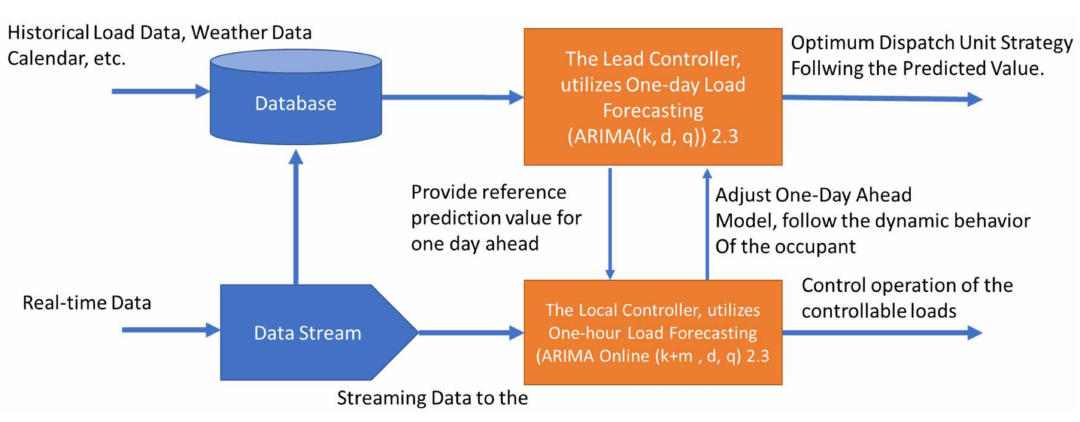
Figure 4. Proposed